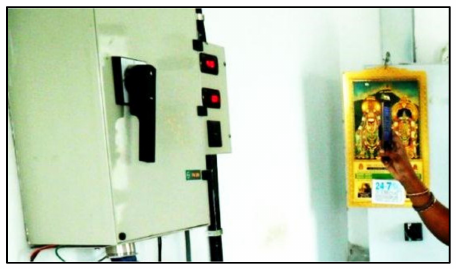
Figure 4. Recording the power meter reading during the mixing